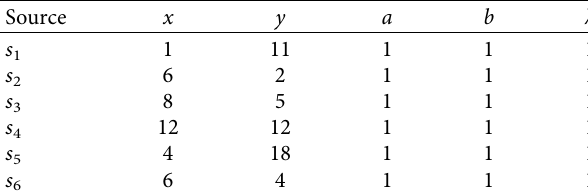
Table 1: The source